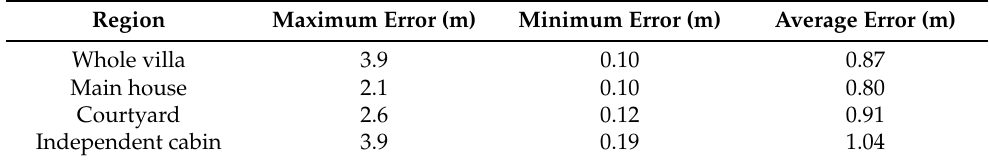
Table 6. Positioning errors in different areas of the